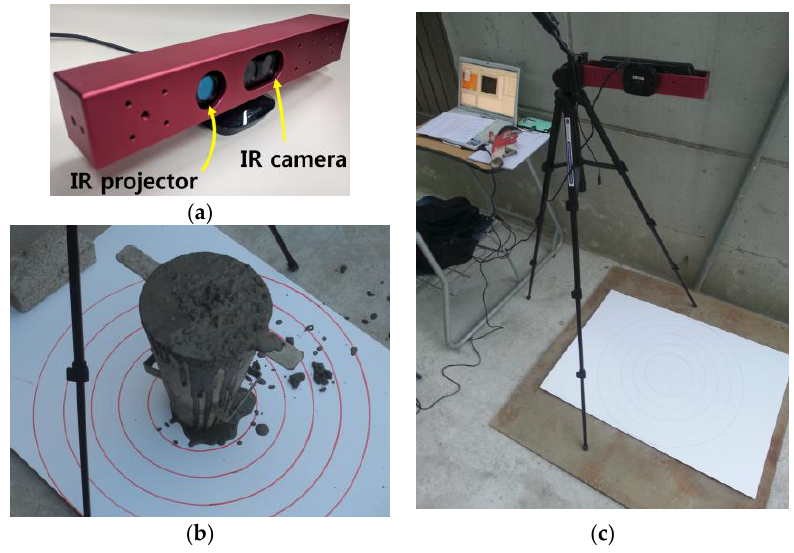
Figure 11. Experimental setup: ( a ) Kinect with camera mounting frame; ( b ) Slump cone in an inverted position; ( c ) Kinect and laptop computer running the 4D slump test program. Table 1. Mixture mass proportions of test material used in the